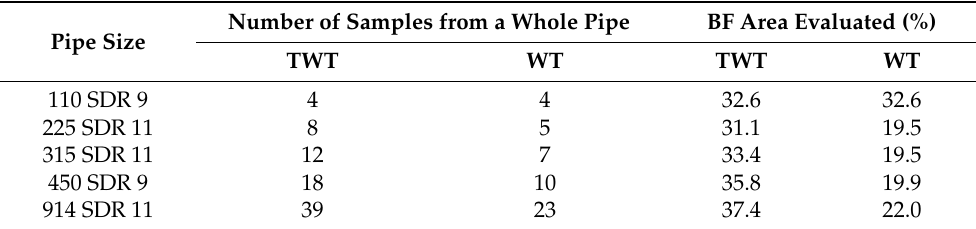
Table 3. Percent BF area per pipe covered by TWT and WT